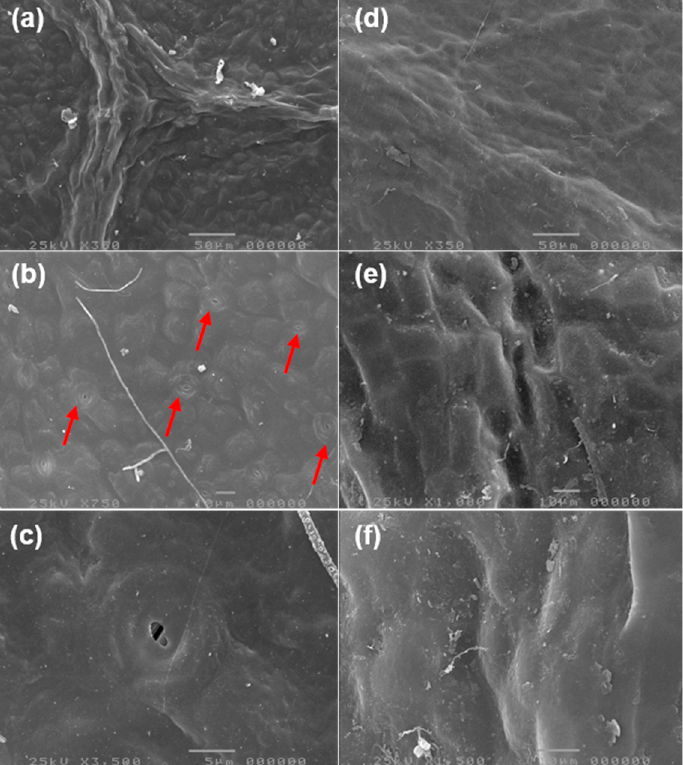
Figure 1. SEM images of Andiroba leaf surface. The following magnifications were applied: ( a ) ×350, ( b ) ×750, and ( c ) ×3500 for Abaxial side and ( d ) ×350, ( e ) ×1000, and ( f ) ×1500 for Adaxial side. The stomata in the abaxial side, highlighted by the red arrows (Figure 1b), are